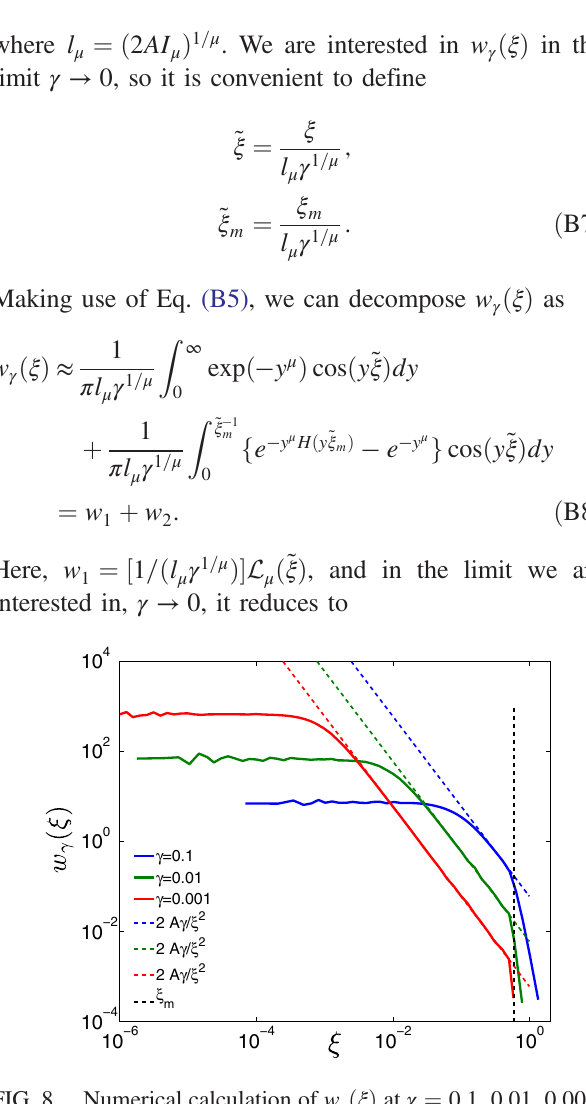
FIG. 8. Numerical calculation of w γ ð ξ Þ at γ ¼ 0 . 1 , 0.01, 0.001, μ ¼ 1 . The colorful dashed lines are the theoretical prediction, for γ 1 = μ ≪ ξ ≪ ξ ξ m . The black dashed line is at m , where the upper cutoff begins to play a